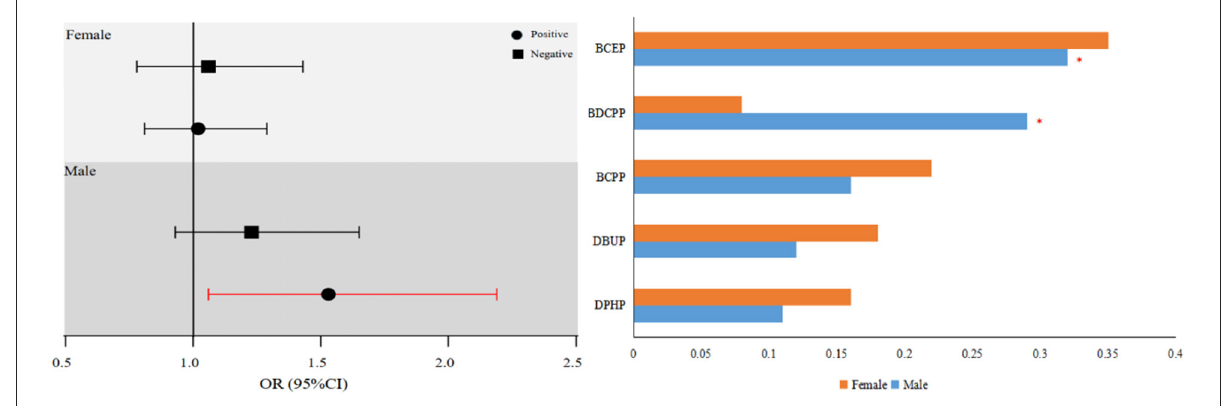
FIGURE1 Associations of OPEs index with NAFLD in both